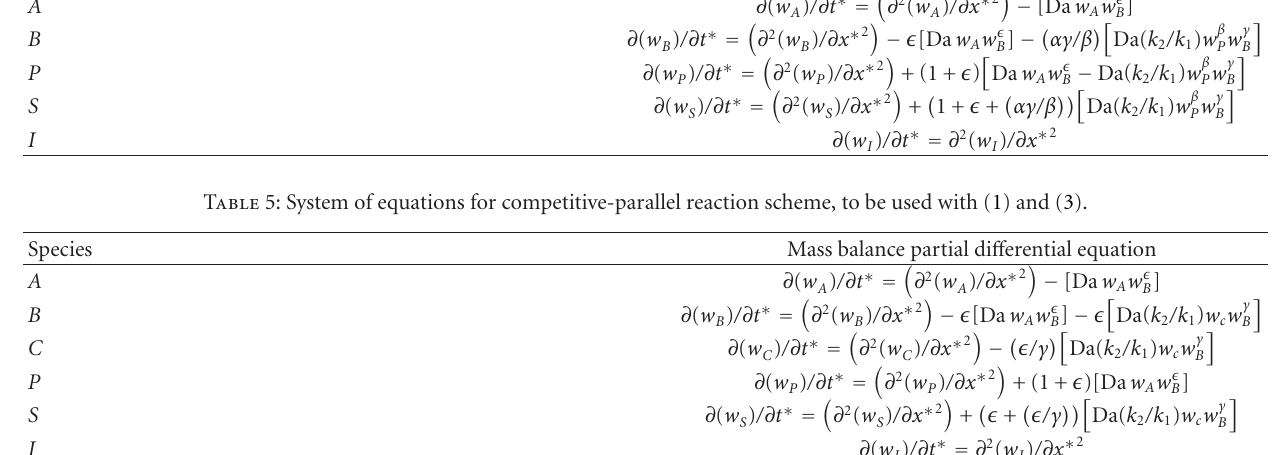
Table 4: System of equations for competitive-consecutive reaction scheme, to be used with (1) and (2). Species